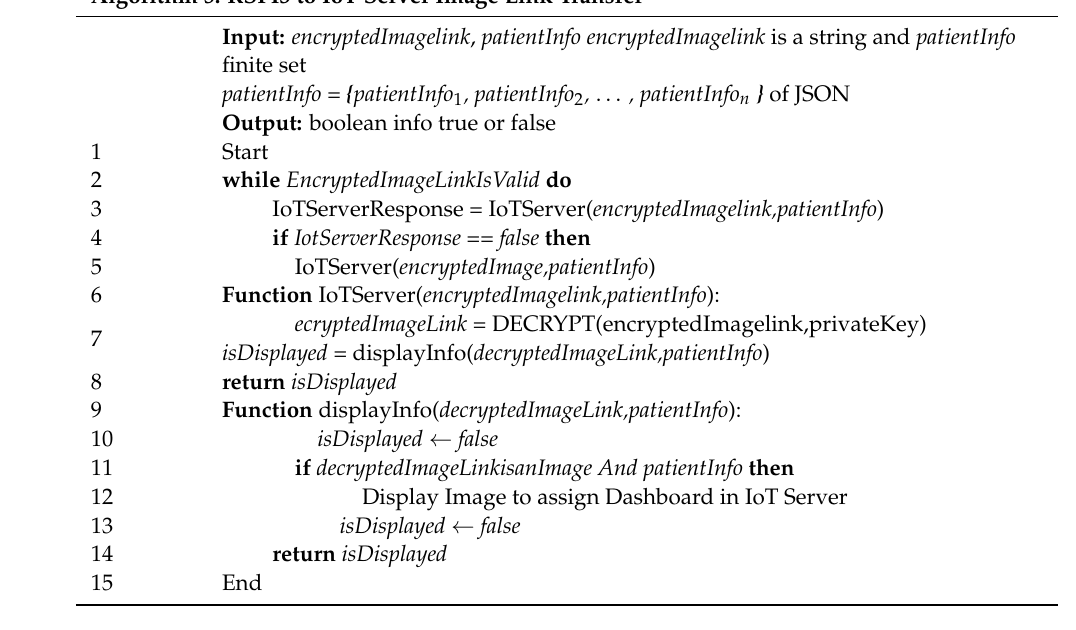
Algorithm 5: RSPI3 to IoT Server Image Link Transfer